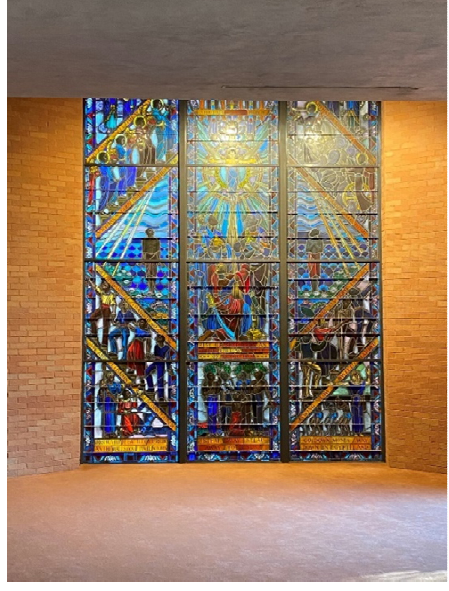
Figure 14. Singing Windows stained glass imagery in the campus chapel at Tuskegee University. Image by the author. January 2020.